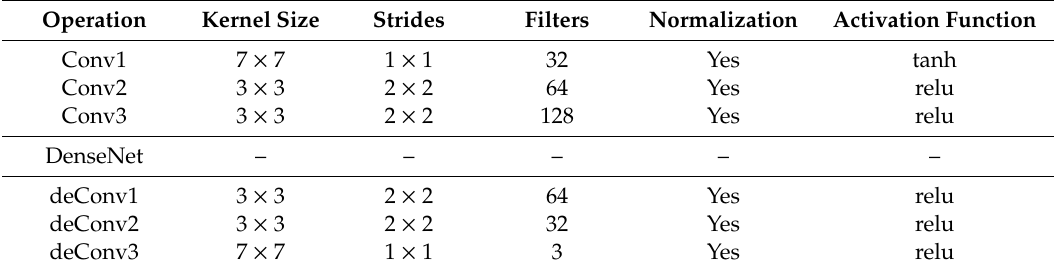
Table 1. The framework of generators G and